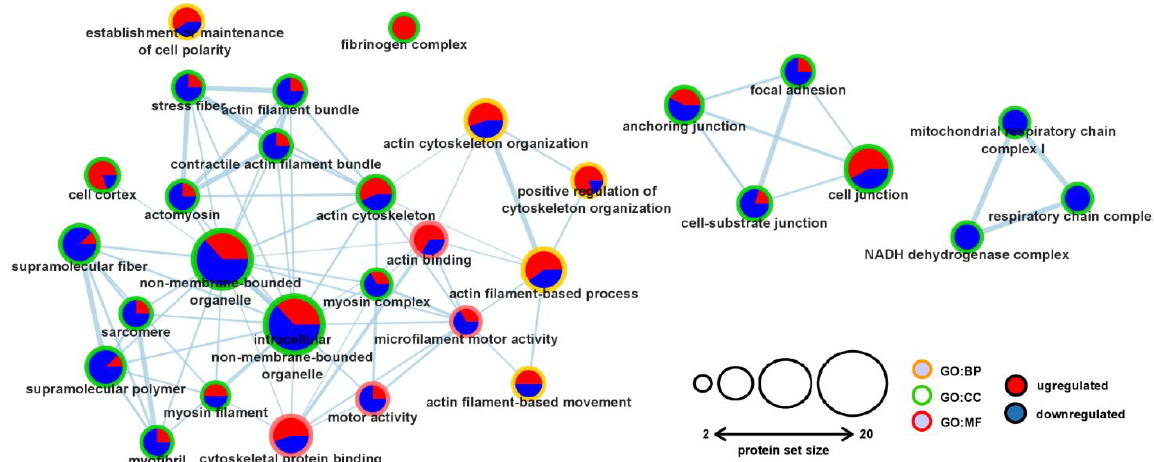
Figure 2. Pathway enrichment analysis revealed changes in the contractile and cytoskeletal systems. Significantly changed proteins were subjected to gene ontology (GO) and pathway enrichment analysis and visualized with Cytoscape v. 3.8.2. (Institute of Systems Biology, Seattle, WA, USA). The size of the nodes corresponds to the number of proteins falling into the respective category, while the GO terminologies are marked as differently colored borders (MF: molecular function, BP: biological process, CC: cellular component). Edges (lines) represent overlaps and functional interactions among the nodes. The width of each edge corresponds to the similarity score between the nodes. The numbers of up (red) and downregulated (blue) proteins were incorporated into the nodes as pie charts.